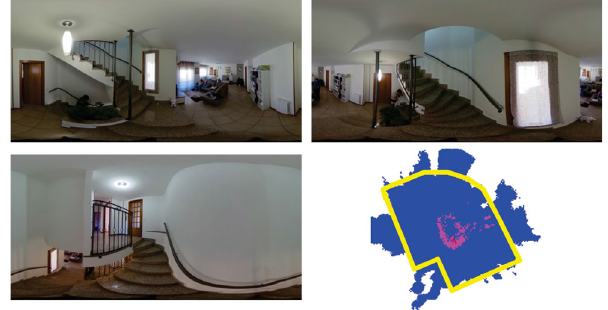
Fig. 14 A failure: a scene with open ceiling, stairs, and a curved wall where our method failed to recover the structure. We show some of the original captured images, the resulting incorrect transform in the 2D plane, and the expected real shape